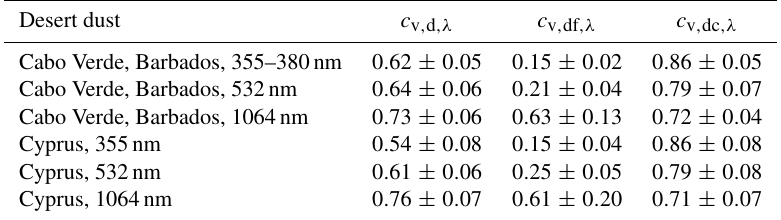
Table 2. Extinction-to-volume conversion factors for desert dust required in Eqs. (16)–(18) in Sect. 4.5. The listed mean values of c v ,i,λ (in 10 − 12 Mm) and SD are computed from averaging of all individual dust observations of these conversion factors of carefully filtered AERONET dust data sets (Cabo Verde and Barbados, Limassol, Cyprus). See the text in Sects. 4.5 and 5 for more details. Desert dust c v , d ,λ